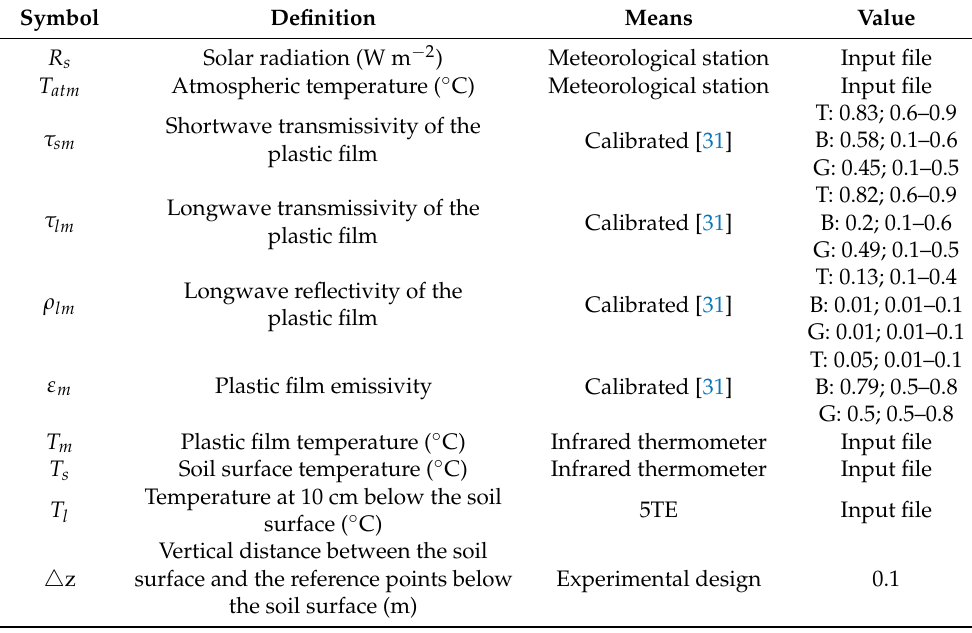
Table 2. List of parameters and their